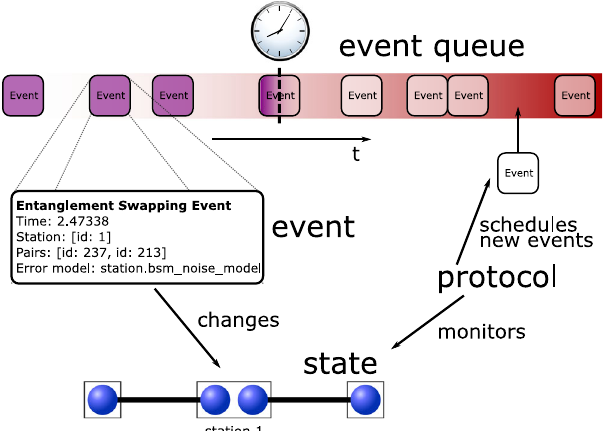
Fig. 6 Schematic representation of the simulation framework. Events are scheduled in an event queue and resolved in order. The state of the simulation, i.e., the location of qubits and the quantum state of the entangled pairs, is changed when events get resolved. The fi gure shows as an example some of the information associated with an entanglement swapping event: at which station the entanglement swapping operation is performed, which entangled pairs are involved in the process, and which error model is relevant to the operation. The current state is monitored and new events are scheduled by the chosen